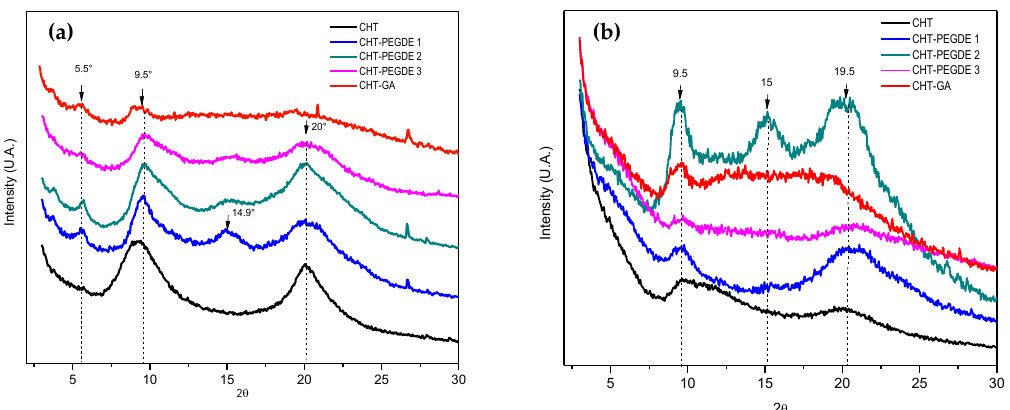
Figure 3. XRD pattern of CHT, glutaraldehyde crosslinked CHT (CHT-GA), PEDGE crosslinked CHT (CHT-PEDGE) at 0.114 mM (1), 0.228 mM (2) and 0.342 mM (3), dried at 25 °C ( a ) and 150 °C ( b ).